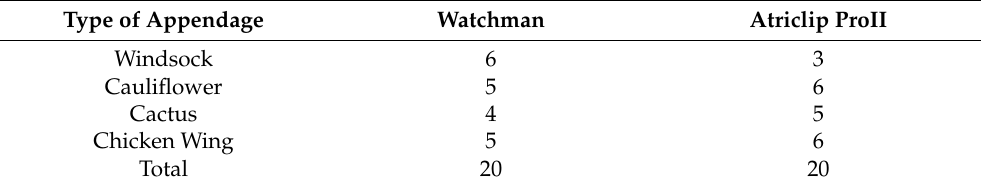
Table 2. Appendage